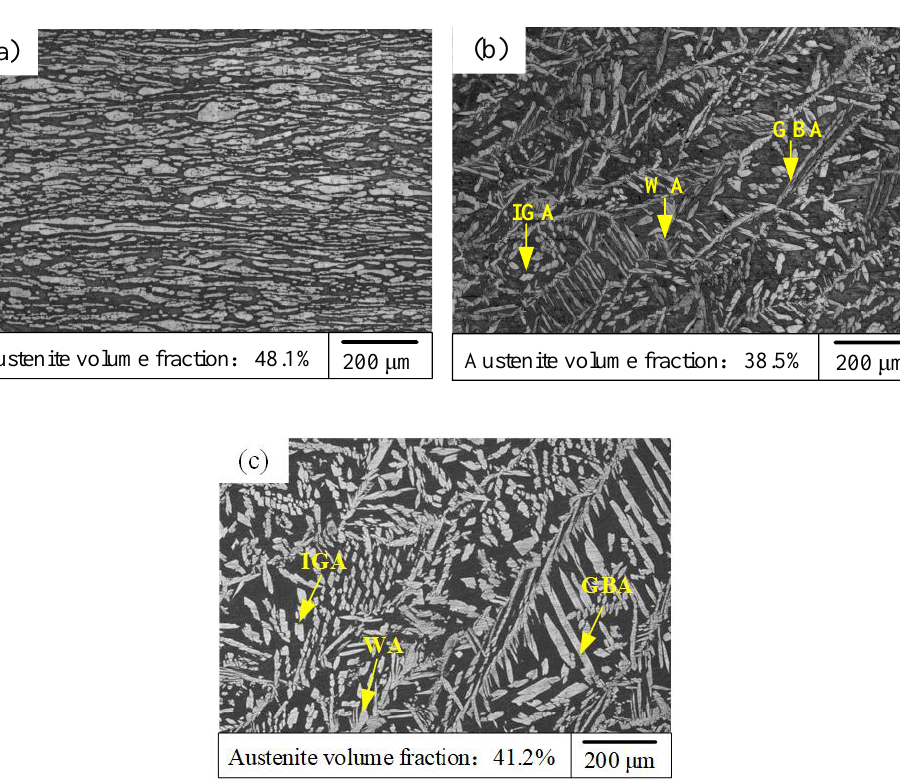
Figure 10. Microstructure of the BM and WM: WM under different welding speeds (Unit: mm/s): ( a ) BM, ( b ) 4.0, ( c ) 3.5.